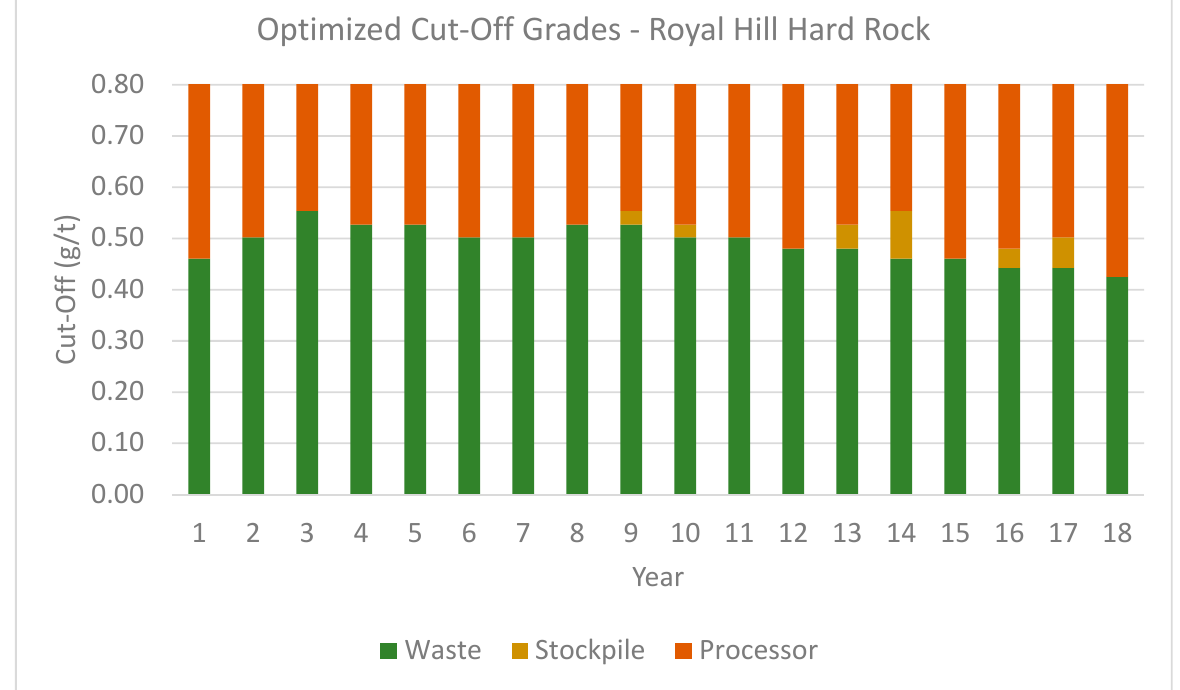
Figure 14. Royal Hill Mine cut-off grade policy.